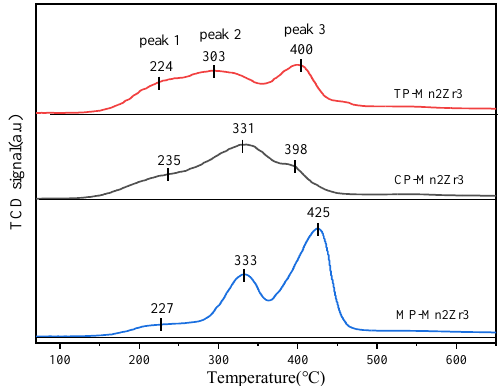
Figure 5. H 2 -TPR profiles of TP-Mn2Zr3, CP-Mn2Zr3, and MP-Mn2Zr3 catalysts.